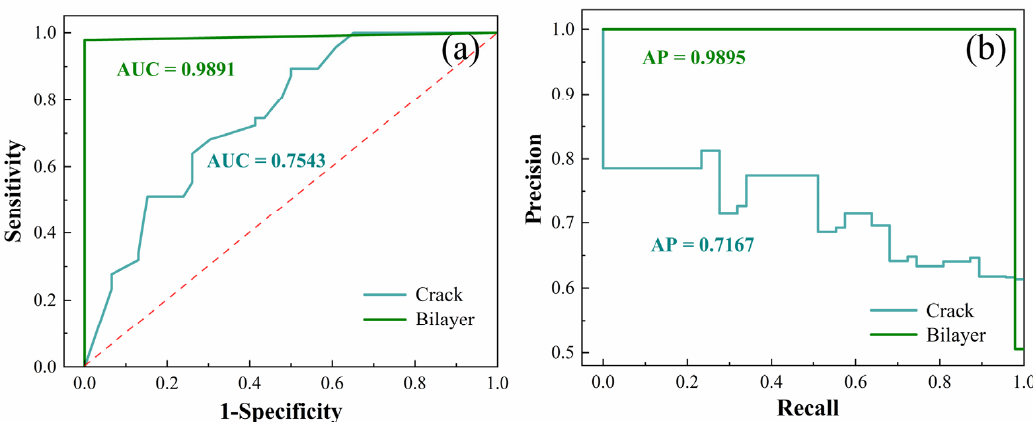
Figure 6. ( a ) Receiver operating characteristic (ROC) curves for the crack and bilayer identification only use the characteristic of the Raman frequency difference. Cyan and green curves show the ROC for two-class classifications of crack/others and bilayer/others, respectively. The red line corresponds to the situation of a random guess. ( b ) Precision-recall (PR) curves for the crack and bilayer identification only use the characteristic of the Raman frequency difference.